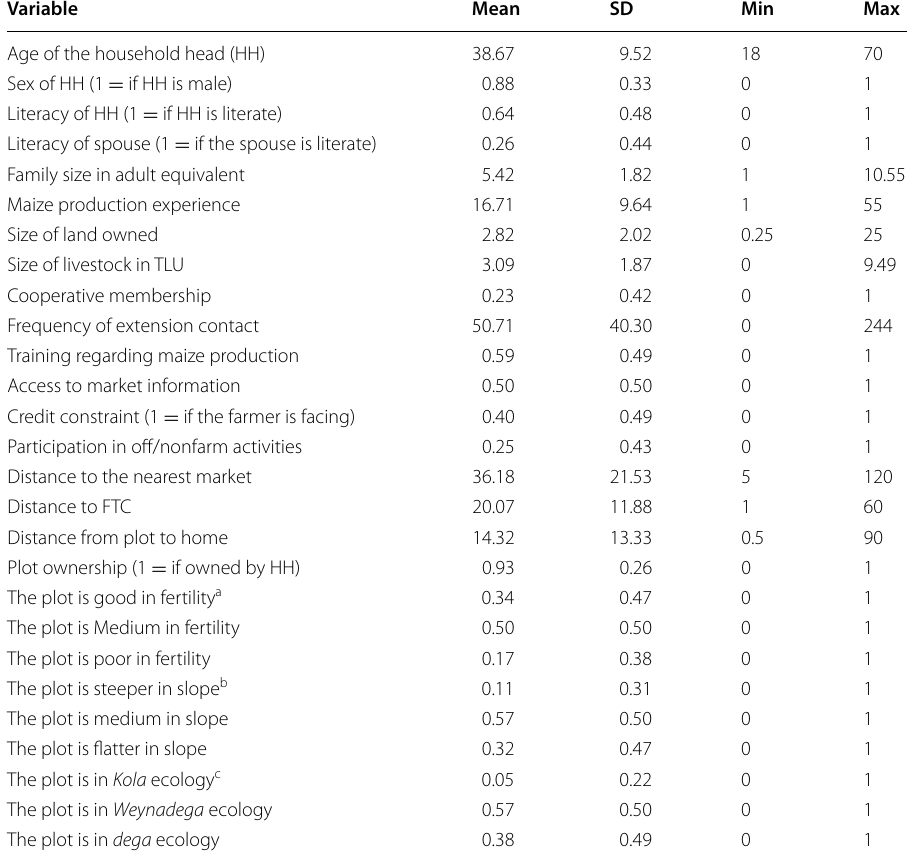
Table 2 Summary statistics of the variables used in the analysis. Source : Own estimation result